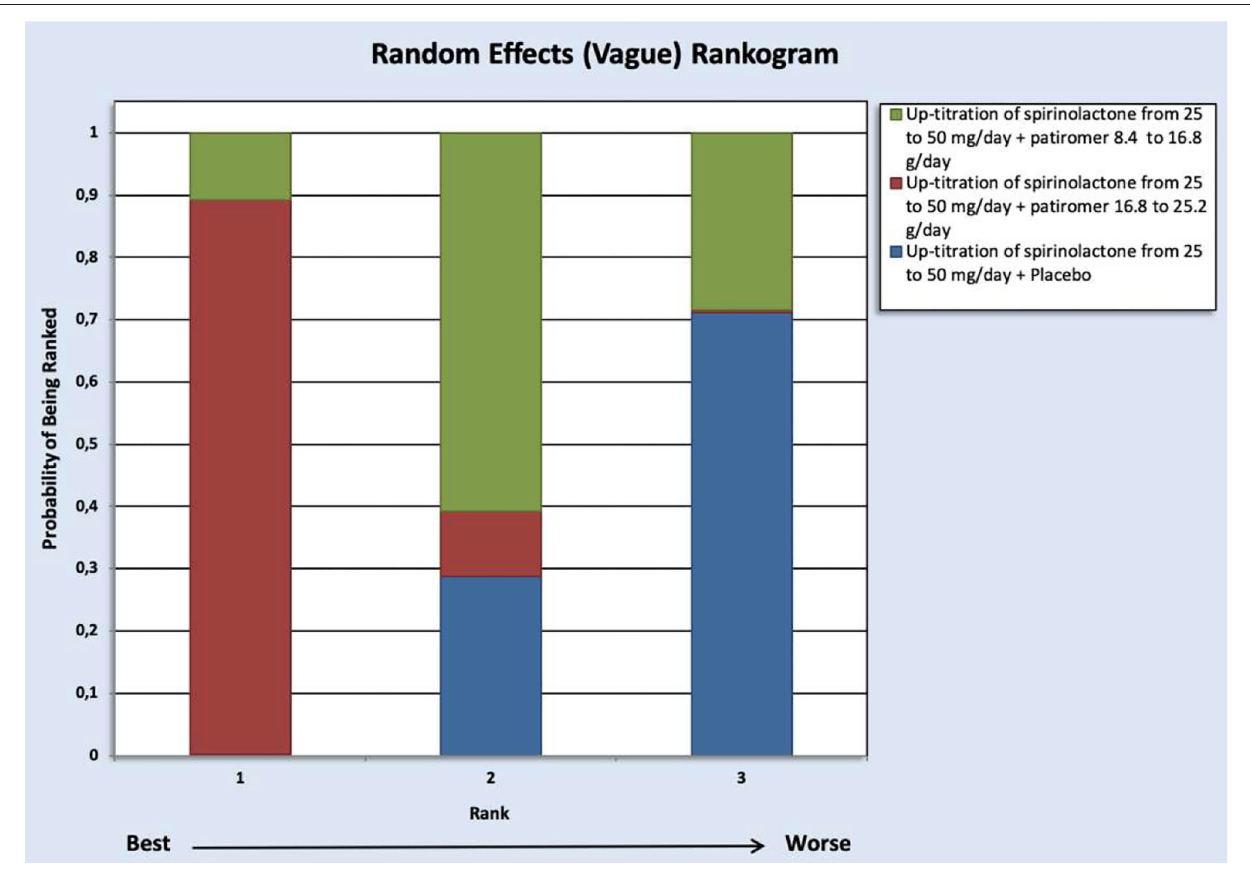
FIGURE 4 | Vague priors random-effects rankogram for the evaluated patiromer doses allowing spironolactone up-titration up to 50 mg/day in subjects with HF or resistant hypertension (who may have or not CKD into KDIGO GFR categories G3a to G5, and were also receiving other RAASi). CKD, chronic kidney disease; GFR, glomerular filtration rate; KDIGO, kidney disease–improving global outcomes; HF, heart failure; RAASi, renin-angiotensin-aldosterone system inhibitors.